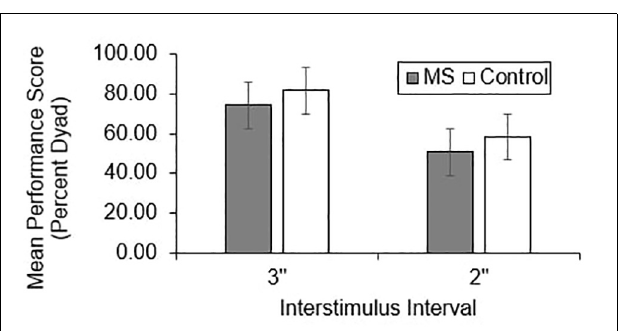
FIGURE 6 | Group difference in percent dyad cognitive fatigability